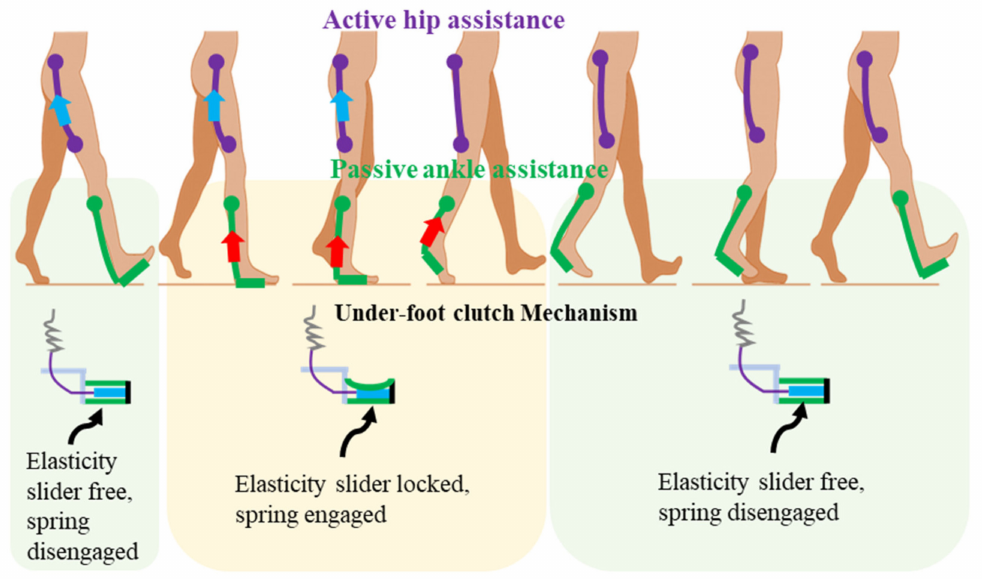
Figure 3. The specific assistance gait phases and realization